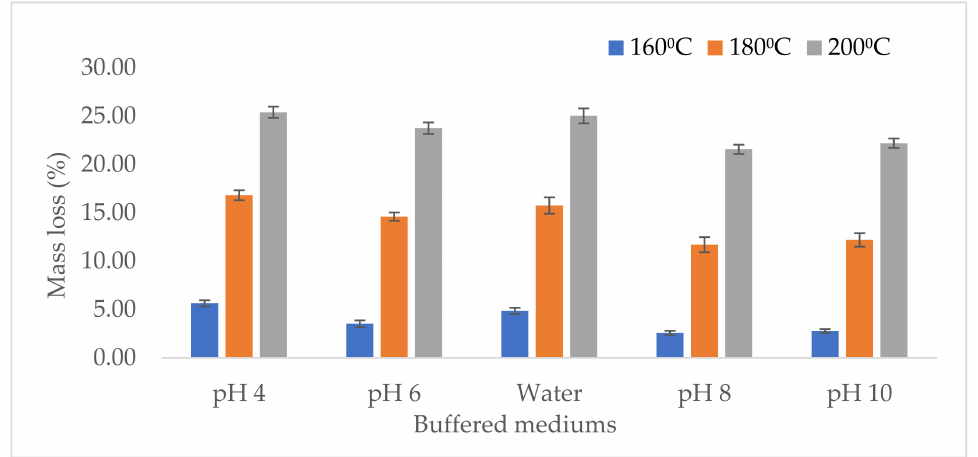
Figure 4. Mass loss (ML%) variations of treated and untreated (control) rubberwood samples in buffered media after the hydrothermal treatment.